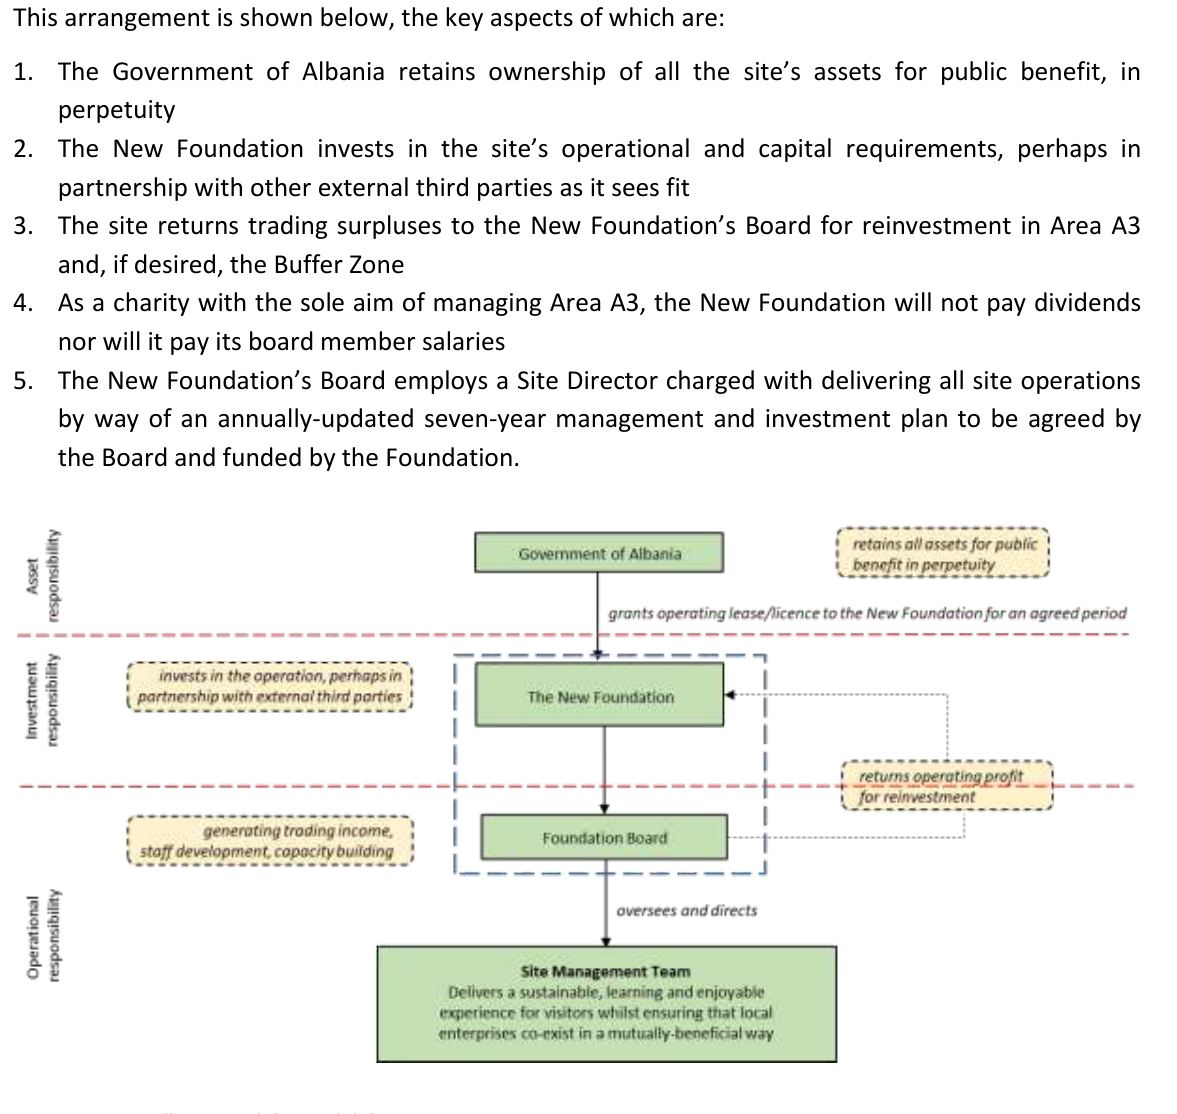
Figure 21: Overall responsibility and